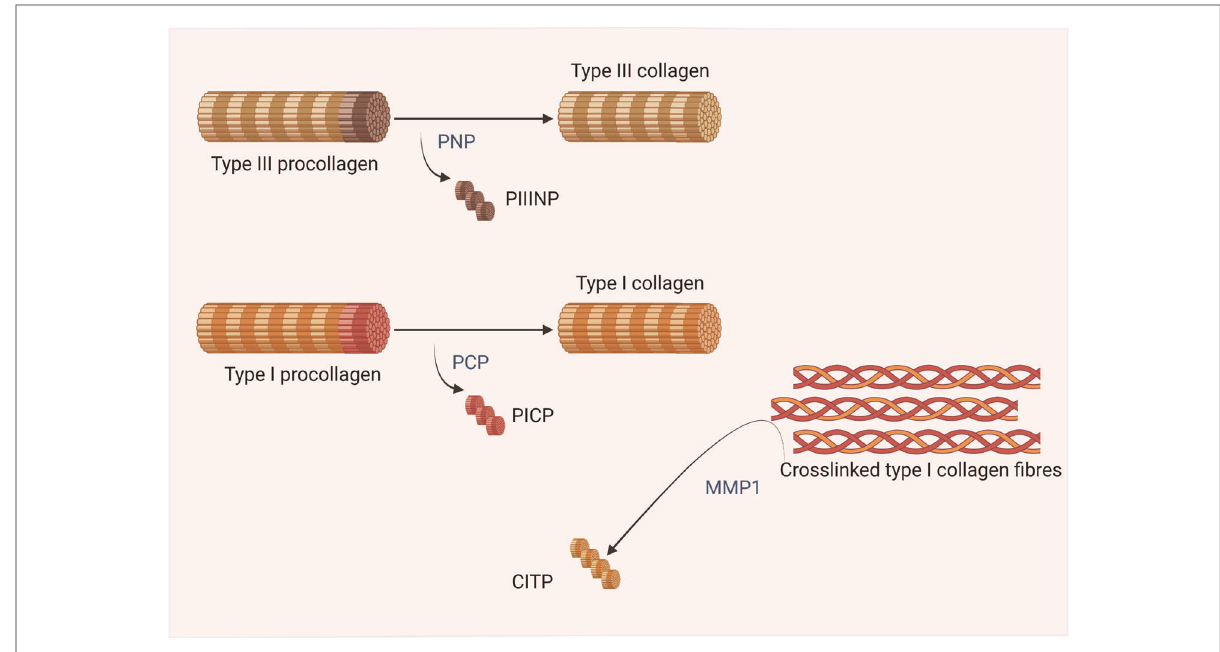
FIGURE 3 Biomarkers of collagen metabolism. Created with BioRender.com.